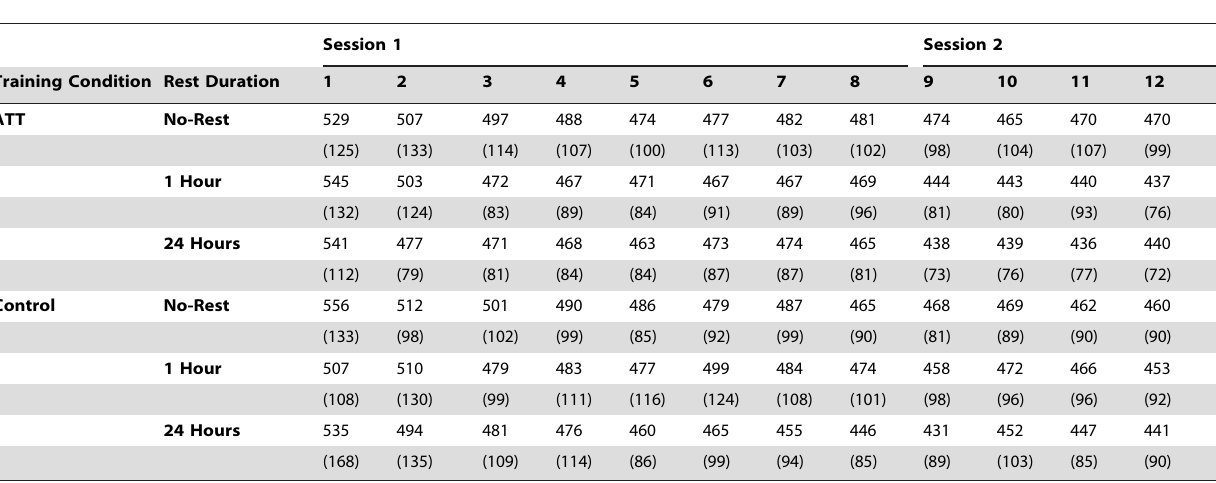
Table 1. Task performance by session, block and experimental